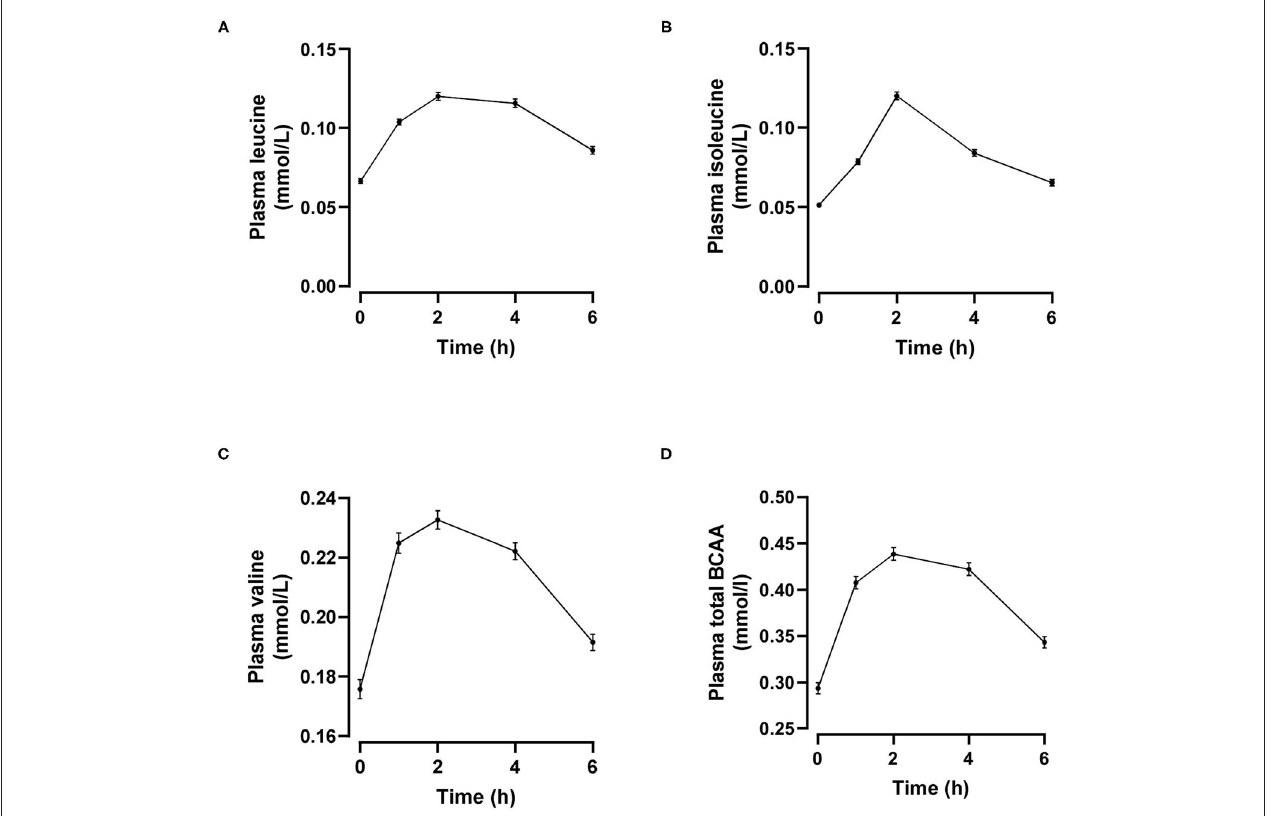
FIGURE 1 | Time course of plasma leucine (A) , isoleucine (B) , valine (C) and total branched-chain amino acids (BCAA, D ) after mixed meal ingestion. Data are mean ± SEM; n = 95.